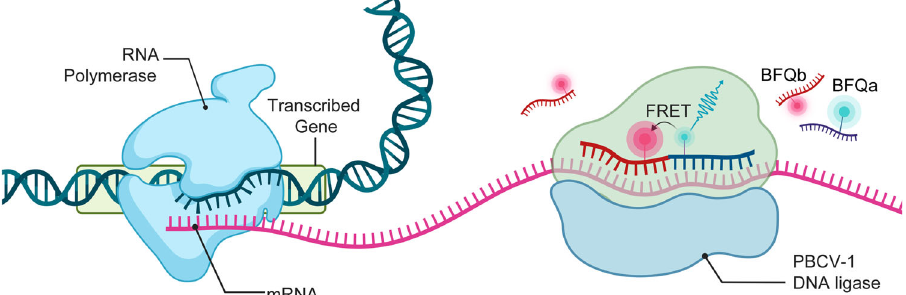
Fig. 1 Schematic overview of the RT-IVT method for IVT-mRNA quanti fi cation. mRNA with the target site for the BFQ probes is transcribed from a DNA template. BFQ probes (BFQa and BFQb) carrying either a donor fl uorophore or quencher fl uorophore are present in the IVT mixture and hybridize to the mRNA. This brings the donor and quencher fl uorophores into close proximity so that FRET can occur. The FRET signal allows quanti fi cation of mRNA concentration in real-time. Figure was created with Biorender